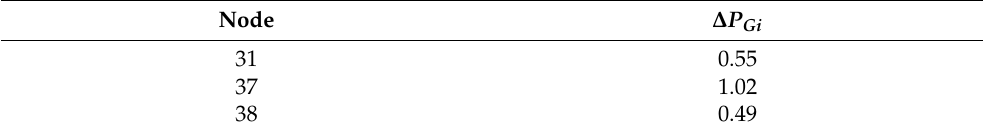
Table 5. Adjustment of generator active output.